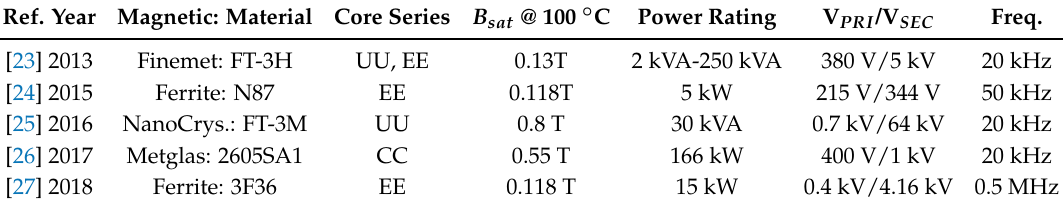
Table 1. Technological advancements in high frequency transformer.